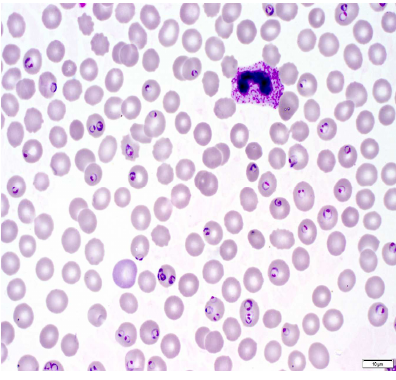
Figure 1. Giemsa-stained thin blood smear from malaria patient [8].